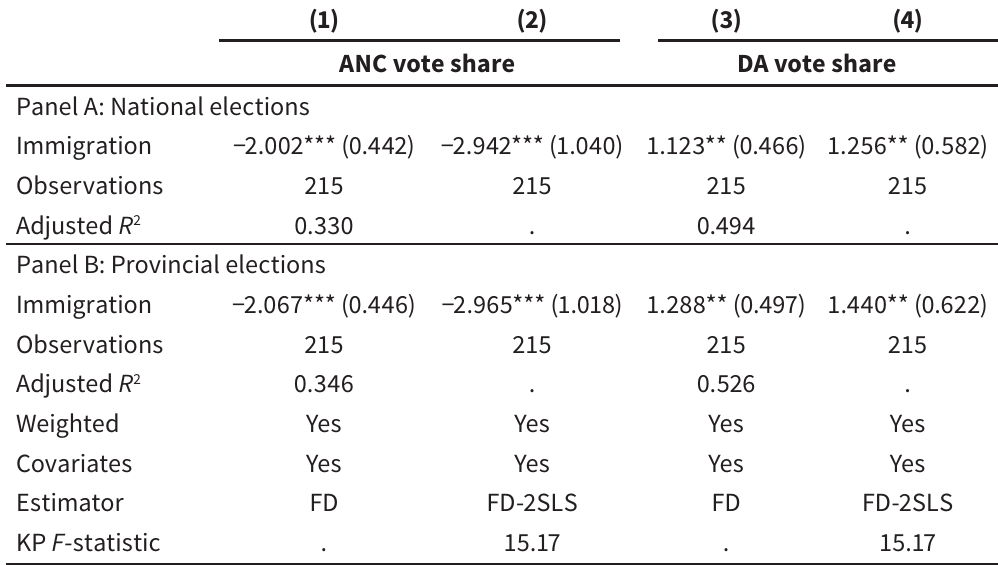
Table A8 IV based on the 1996 census